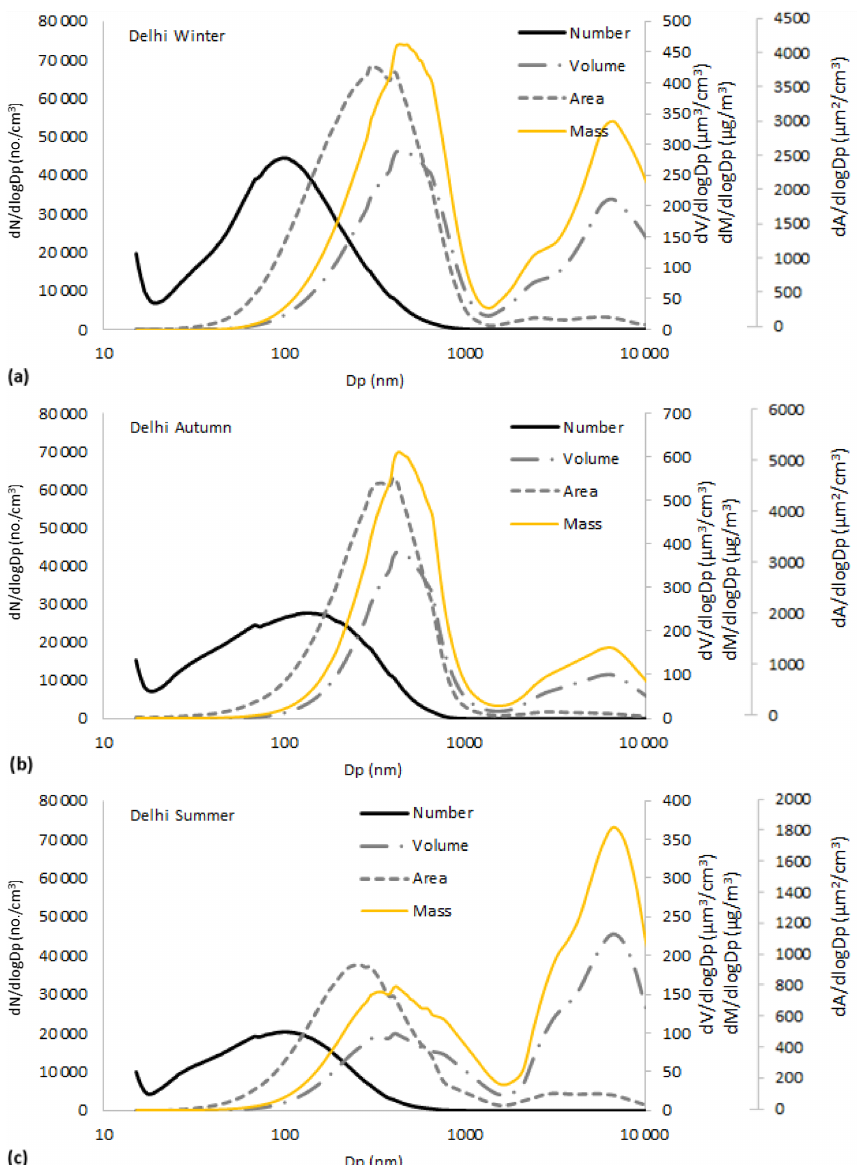
Figure 9. Hourly average particle number, volume, and area distributions in the winter (a) , autumn (b) and summer (c) in